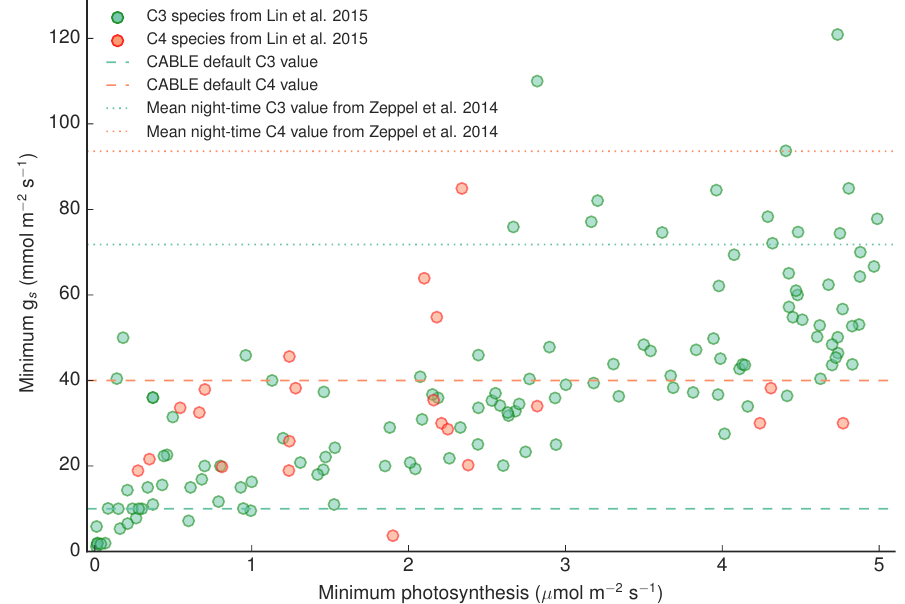
Figure A2. Minimum measured stomatal conductance ( g s ) as a function of corresponding photosynthesis rate, for each data set in the Lin et al. (2015) synthesis g s database with minimum photosynthesis rate < 5molm − 2 s − 1 . Data are separated into C3 (131 data sets) and C4 species (22 data sets). Also shown for comparison are the default g 0 values used in CABLE, as well as average night-time g 0 values for C3 and C4 plants, calculated from Fig. 2 in a review by Zeppel et al.